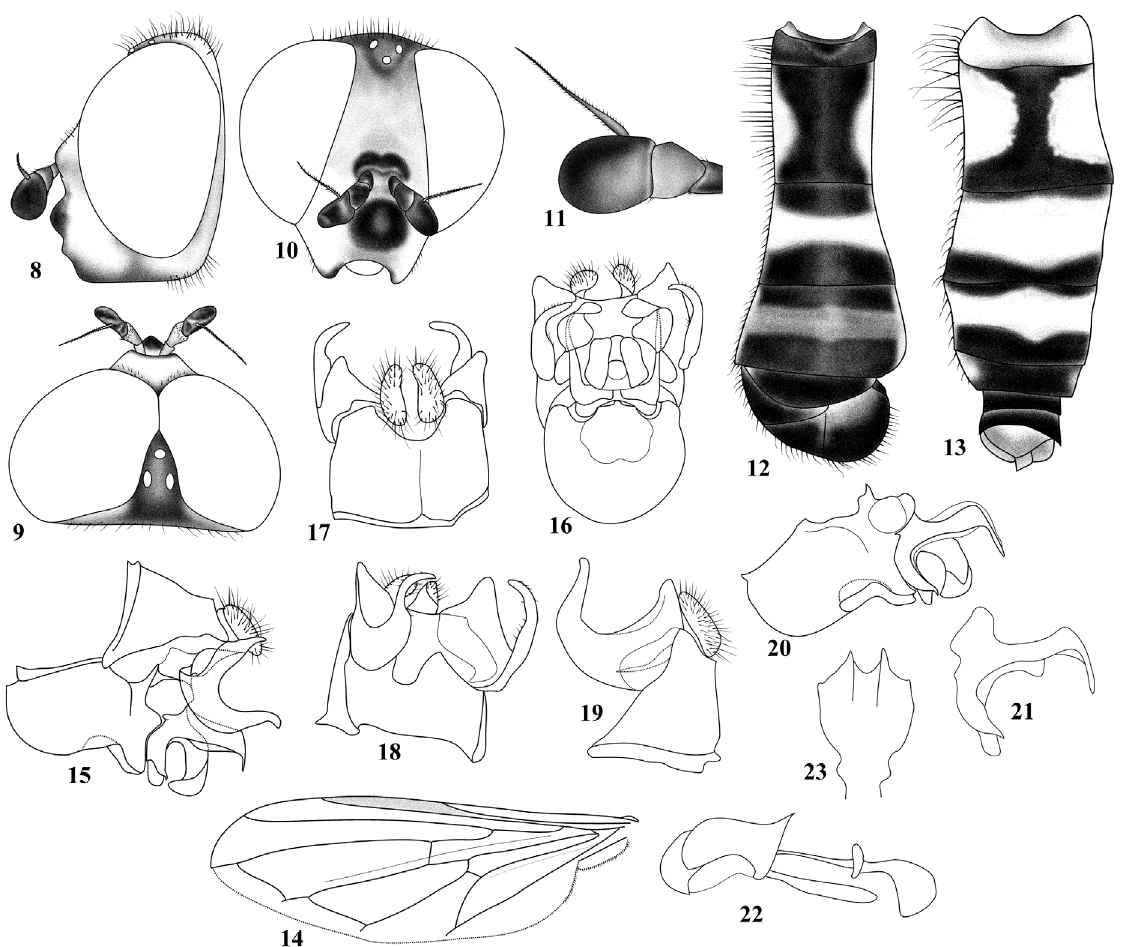
Figs 8−23. Biema wanglangensis Huo & Zhao gen. et sp. nov. 8 . Male, head in lateral view. 9 . Male, head in dorsal view. 10 . Female, head in frontal view. 11 . Antenna, inside view. 12 . Male, abdomen in dorsal view. 13 . Female, abdomen in dorsal view. 14 . Wing. 15 . Male, terminalia in lateral view. 16 . Male, terminalia in ventral view. 17 . Male, epandrium and appendages in dorsal view. 18 . Male, epandrium and appendages in ventral view. 19 . Male, epandrium and appendages in lateral view. 20 . Male, hypandrium and appendages in lateral view. 21 . Superior lobe in lateral view. 22 . Phallus. 23 . Distal end of phallus in dorsal